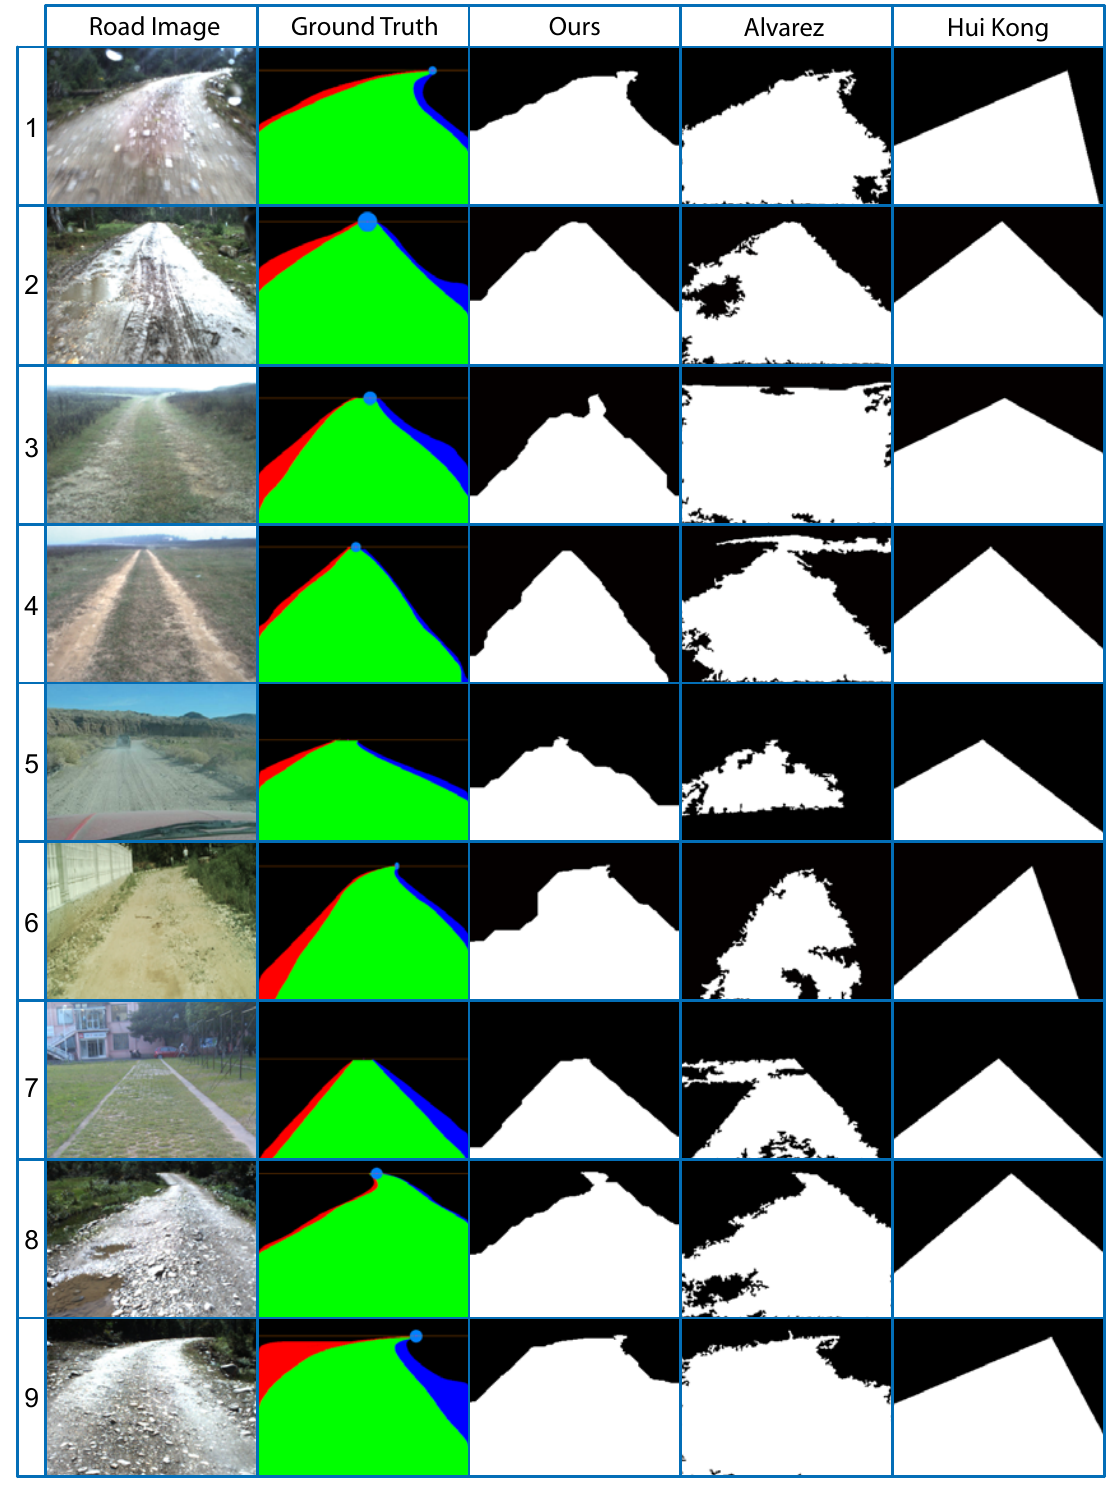
Figure 23. Qualitative comparisons between different methods. Road and background regions in Columns 3–5 are marked with white and black,